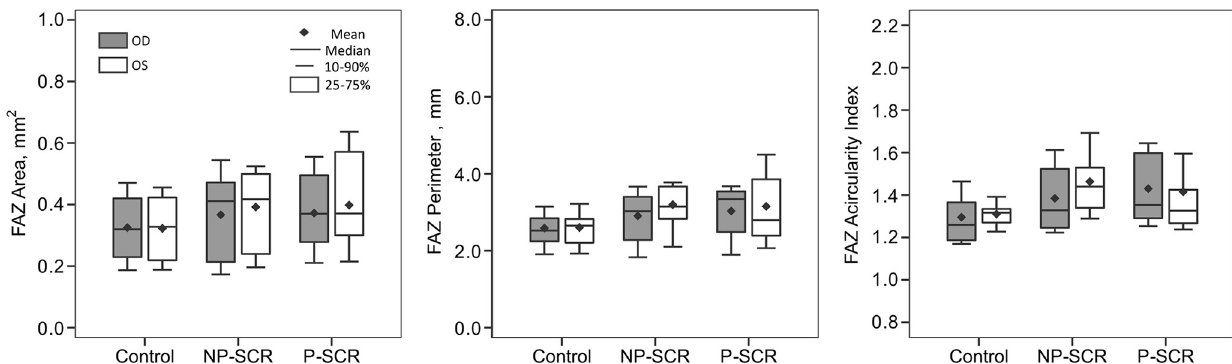
Fig 1. Boxplots of FAZ metrics for the right and left eyes of NP-SCR, P-SCR, and unaffected controls.